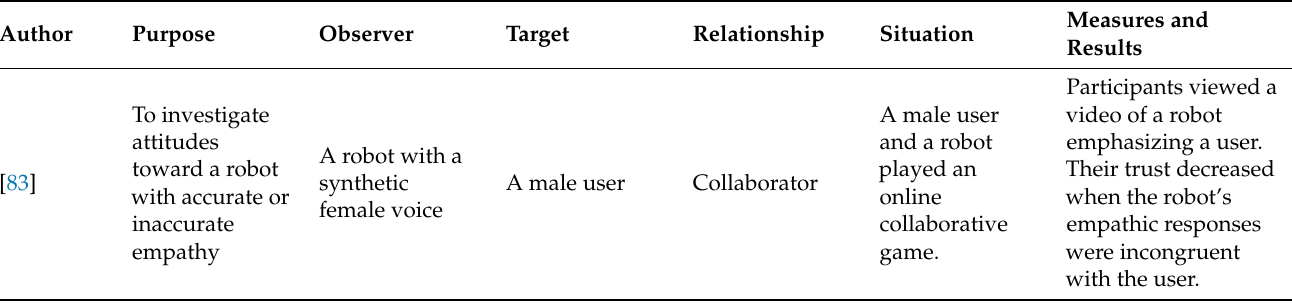
Table 5. Studies on empathic